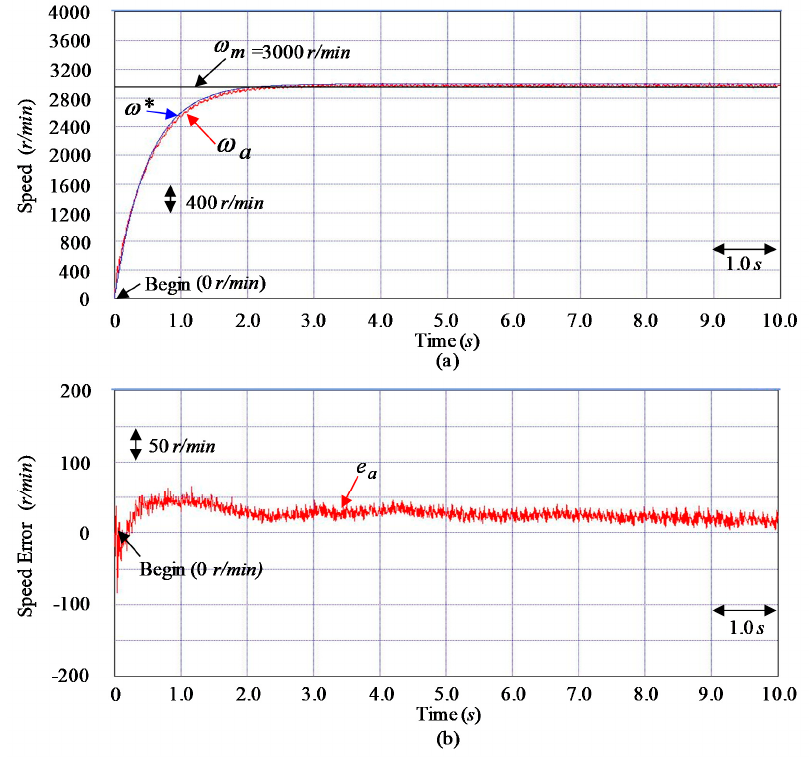
Figure 10. Tested results for the SIM expelling CVT organized system at the tested Event E2 case by using the controller CT2: ( a ) speed response, and ( b ) speed discrepancy response .